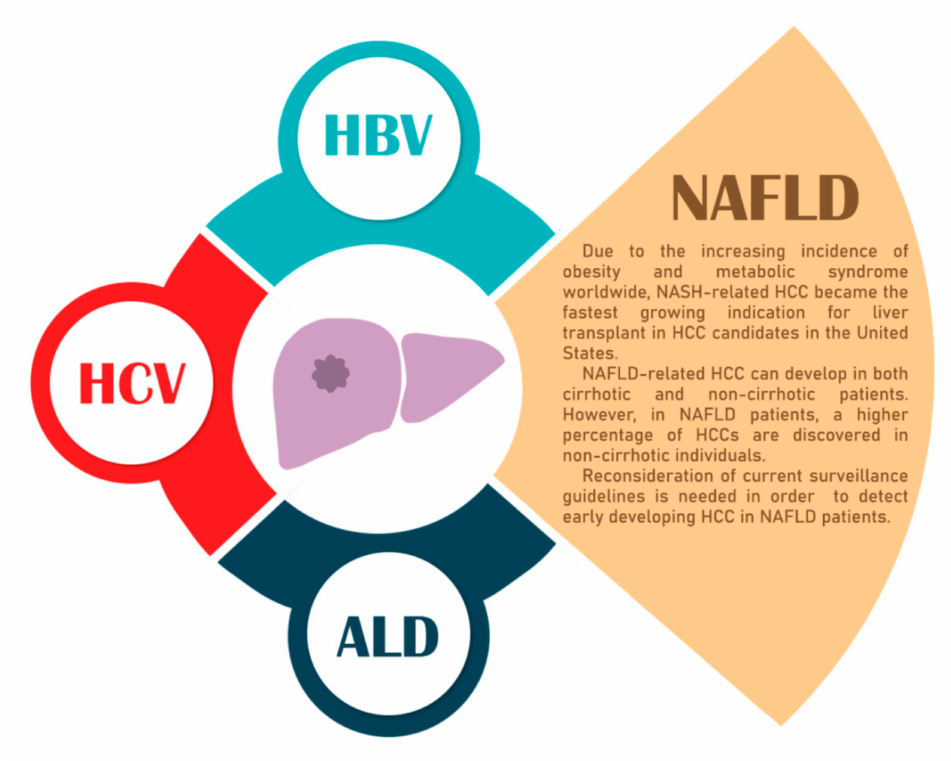
Figure 1. A graphical representation of the main hepatocellular carcinoma (HCC) etiologies. The main risk factors in HCC development are HBV, hepatitis C virus (HCV), alcoholic liver disease (ALD), and non-alcoholic fatty liver disease (NAFLD). The increasing prevalence of NAFLD and its silent progression towards fibrosis, cirrhosis, and HCC requires new non-invasive diagnostic methods. NASH, non-alcoholic